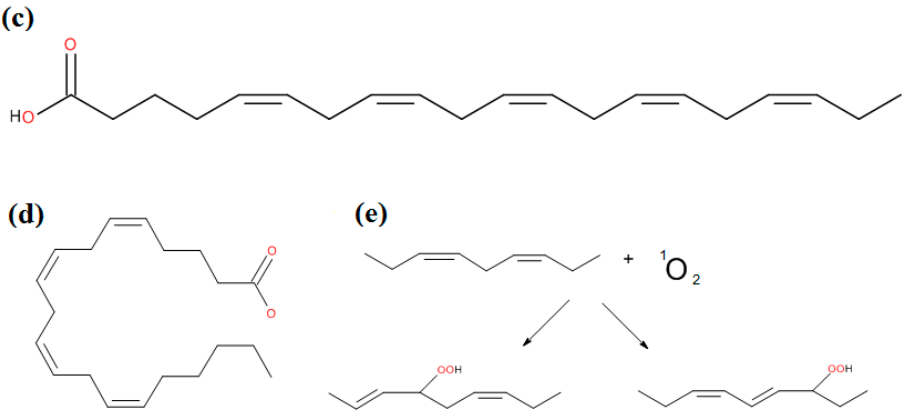
Figure 6. The relationship between antimicrobial activity and properties of microorganism: ( a ) the graph of the inhibition percent and surface area of spores; ( b ) photooxidation of ergosterol to ergoperoxide in ascomycota fungal membrane [34]; ( c ) eicosapentaenoic acid (EPA); ( d ) arachidonic acid (AR); ( e ) reactions on double bonds by singlet oxygen in unsaturated fatty acid chains.